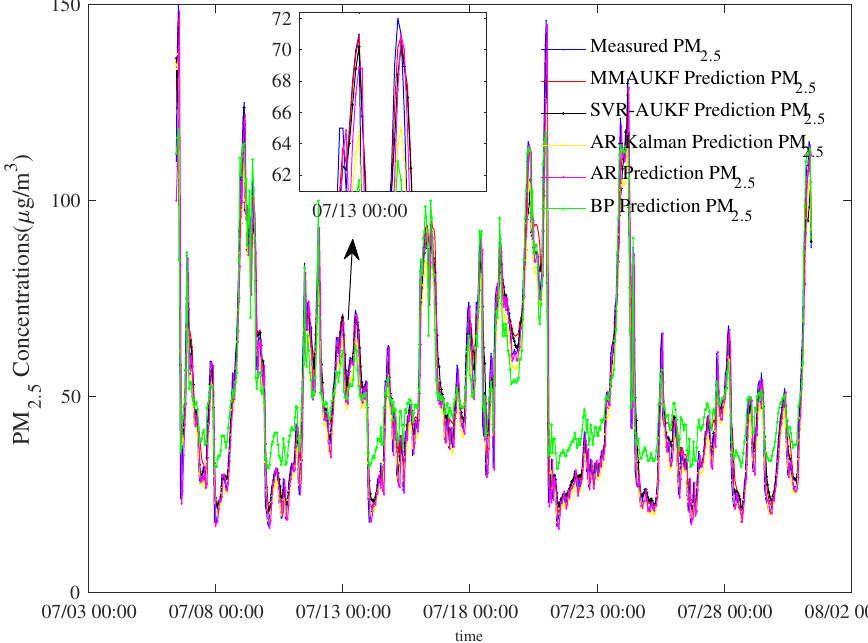
Figure 15. The comparison results of the proposed MMAUKF method and SVR-AUKF, AR-Kalman, AR and BP